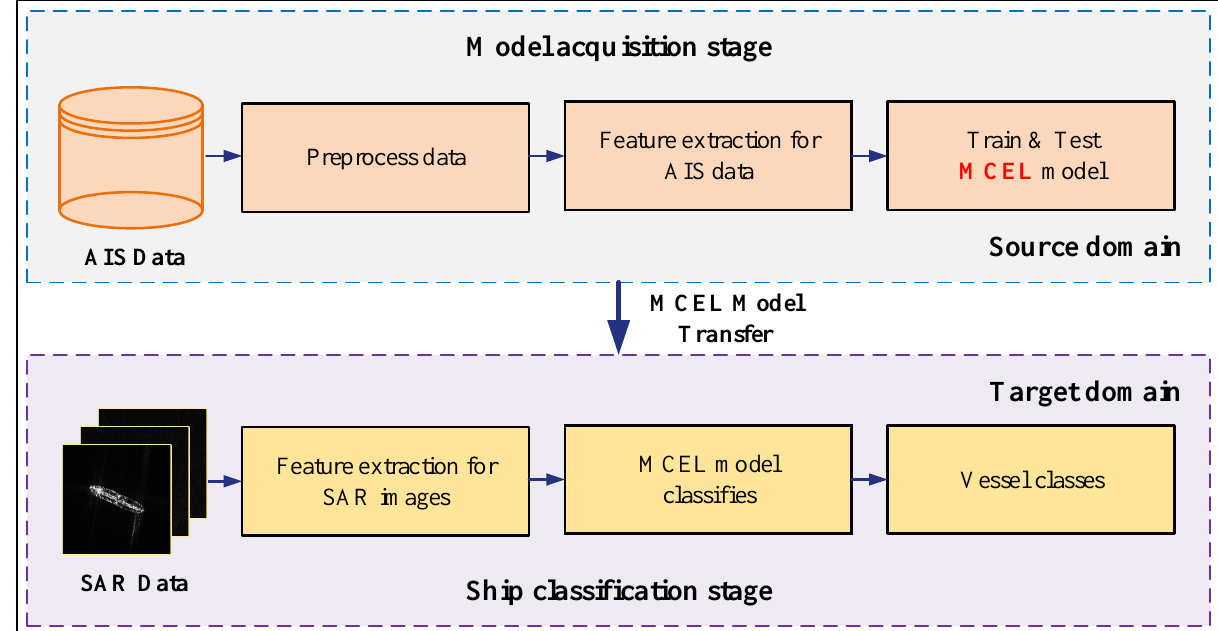
Figure 1. The overall architecture of the proposed method.